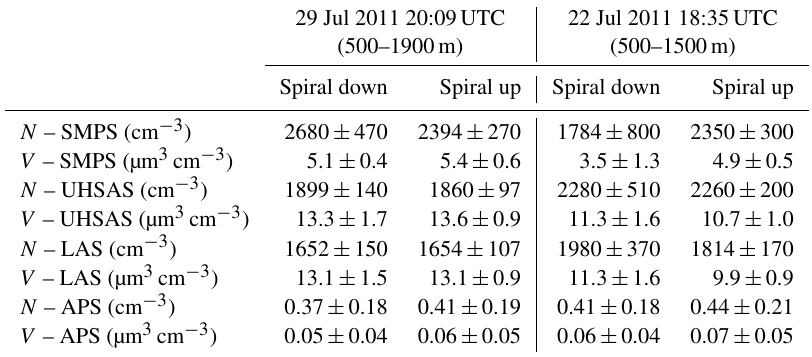
Table 3. Mean values in the planetary boundary layers of total number of particles ( N ) and volume of particles ( V ) obtained by SMPS, UHSAS, LAS and APS instruments. Data are representative of dry